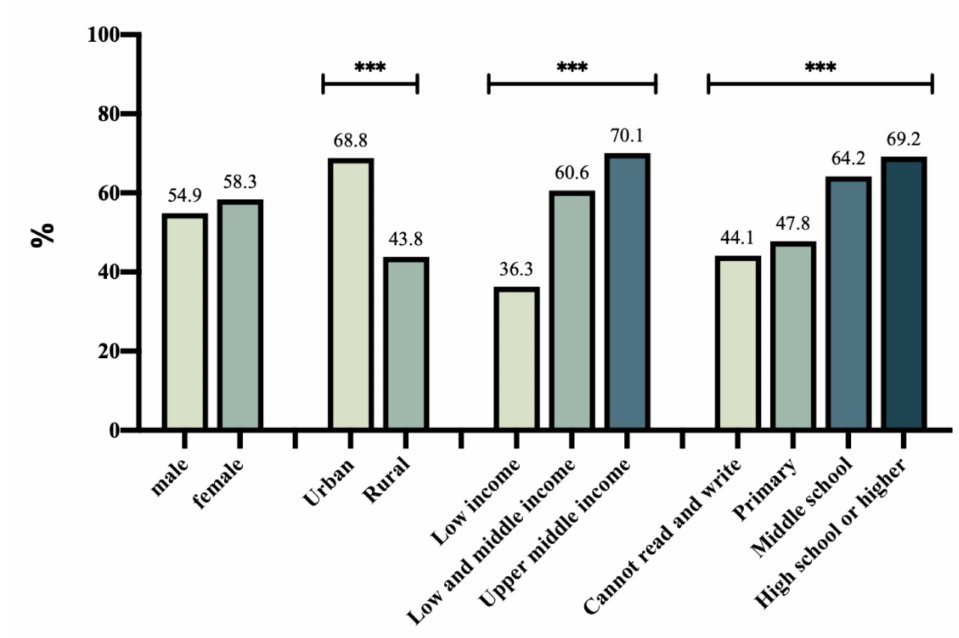
Figure 2. Percentage of participants who always wore masks outdoors. (***, p < 0.01).